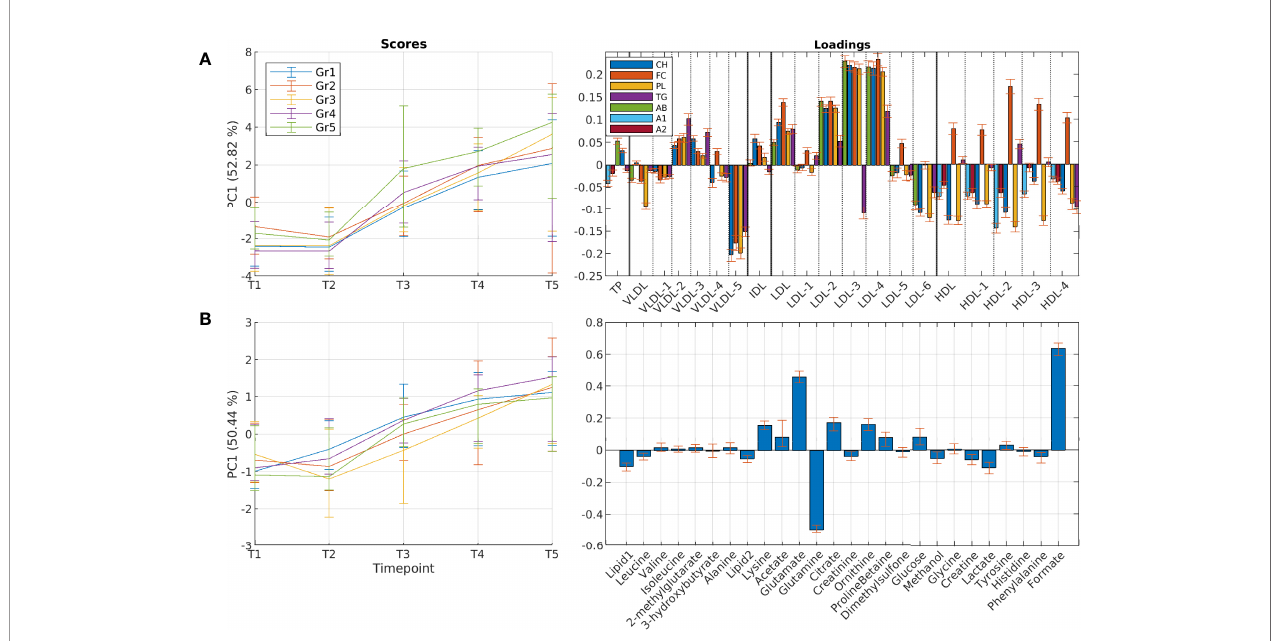
FIGURE 2 | Longitudinal development of circulating lipoprotein subfractions and metabolites in patients receiving different treatment regimens. Results show scores and loadings from RM-ASCA+ analysis including time, treatment, and time-treatment interactions for (A) lipoprotein subfractions and (B) circulating metabolites. The scores (left) show the overall development for different treatment groups over time (T1-T5), and must be interpreted together with the corresponding loadings (right). An increase in score value means that the treatment groups get increased levels of variables with positive loadings and decreased levels of variables with negative loadings. All treatment groups show clear changes over time both in lipoprotein and metabolite pro fi les. Treatment is sum coded to detect possible treatment groups deviating from the main trend. A1, apolipoprotein-A1; A2, apolipoprotein-A2; AB, apolipoprotein-B; CH, esteri fi ed cholesterol; FC, free cholesterol; Gr, group; PC, principal component; PL, phospholipids; TG,